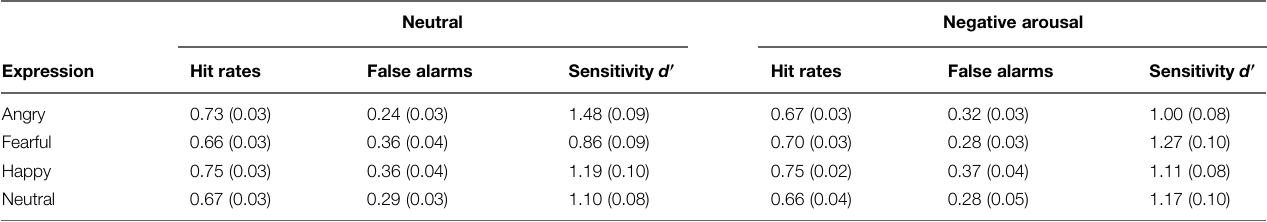
TABLE 1 | Mean d (cid:2) scores for the mood conditions of Experiment